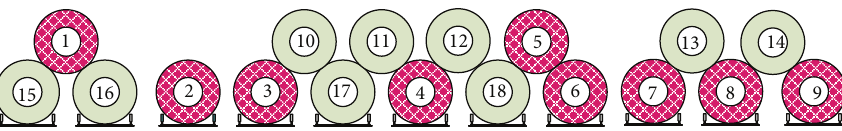
Figure 3: Side view of a row in steel coil